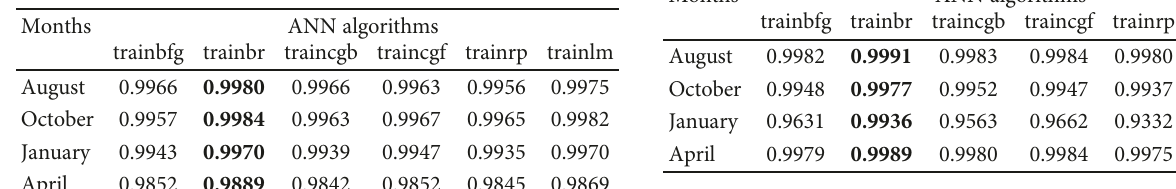
Figure 4: Model of arti fi cial neural networks [29]. Table 1: ANN algorithm estimation results in Adiyaman.